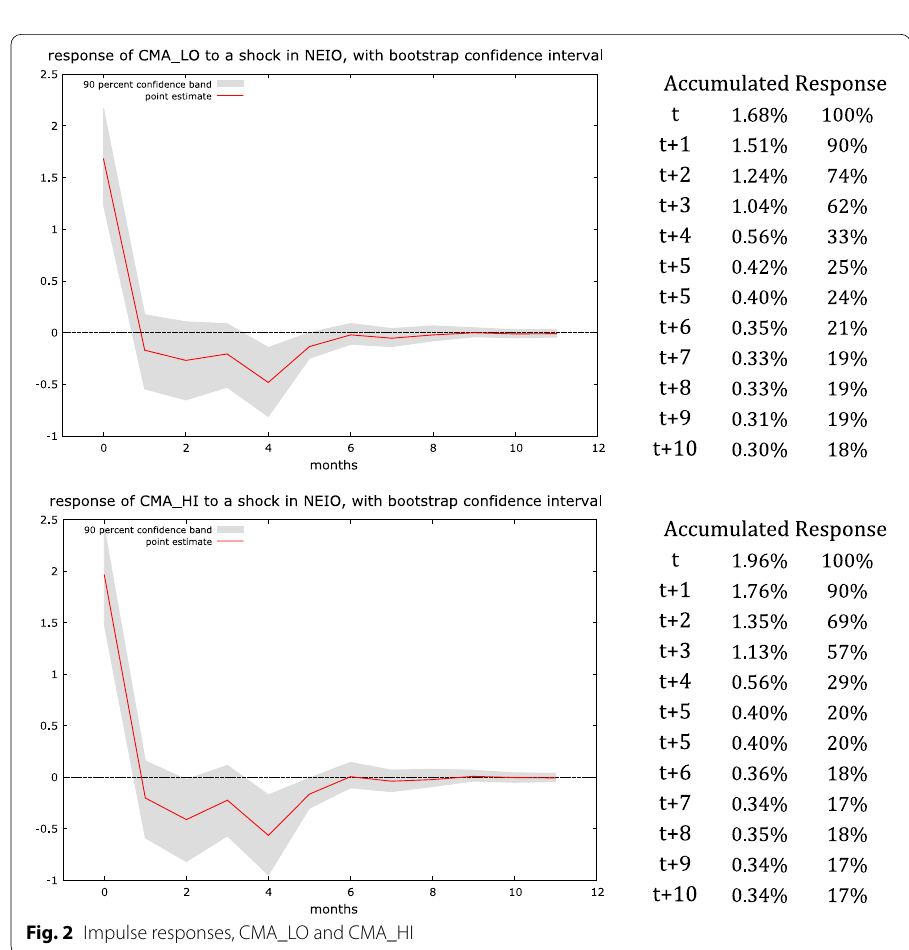
Fig. 2 Impulse responses, CMA_LO and